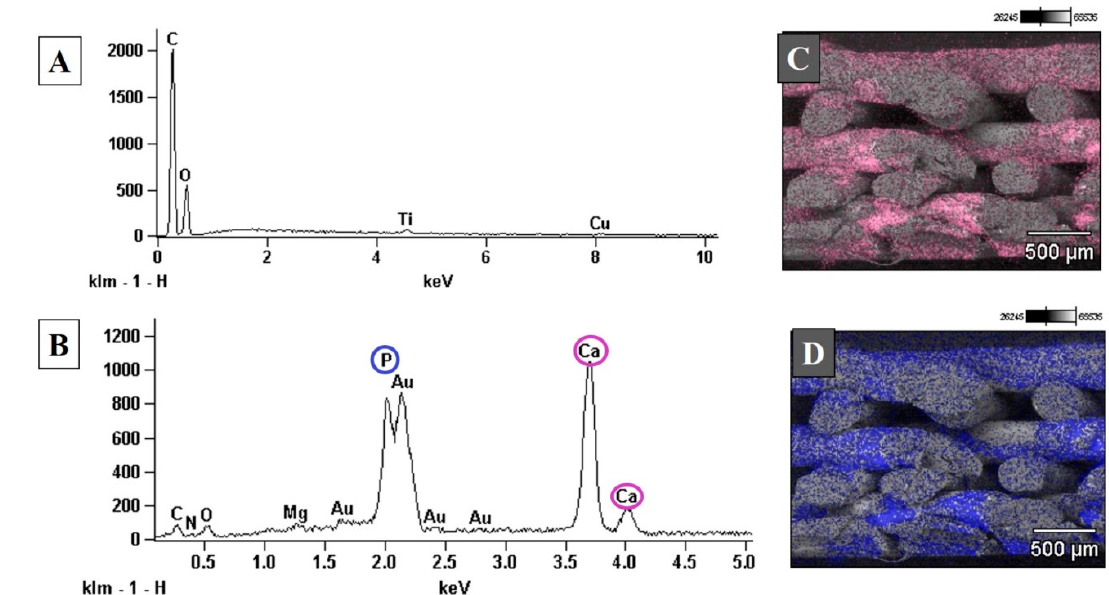
Polymers 2021 , 13 , x FOR PEER REVIEW Figure 4. EDS spectrum of the top surface uncoated PLA ( A ) and PLA-CaP ( B ) scaffolds. Element mapping image for calcium, imaged in pink, ( C ) and phosphorous, imaged in blue, ( D ) of the fracture surface of PLA-CaP scaffold.